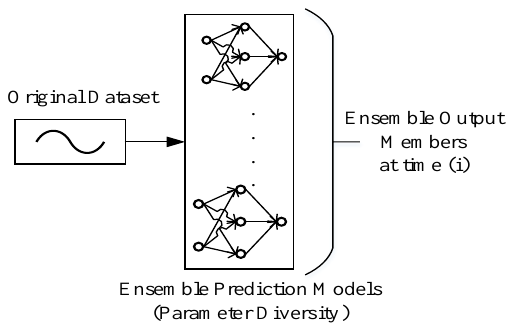
Figure 3. Parameter diversity ensemble forecasting diagram, where the networks that are used in ensemble model are be different from each other (i.e., different parameters are used for each one) while using the same dataset to train all networks. Time (i) represents the predicted time steps.